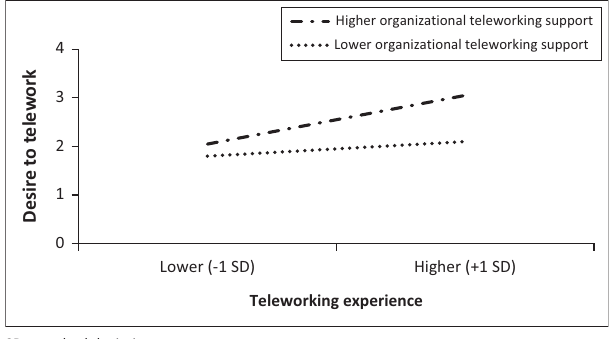
FIGURE 3: Simple slopes between employee teleworking experience and desire to telework at different levels of perceived organisational telework